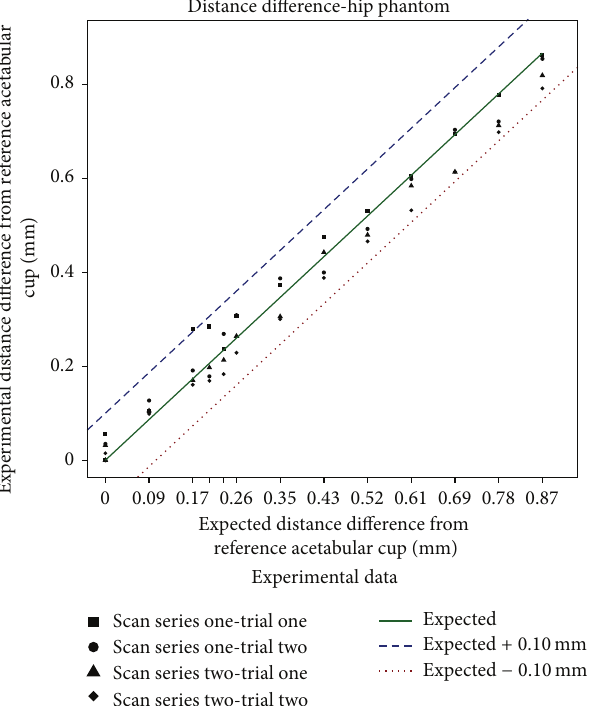
Figure 7: The calculated CupHeadSeparation plotted against the expected CupHeadSeparation from Table 1, for scan series one and two (both trials). Lines are drawn at the exact expected value and at ± 0.1 mm demonstrating the data were within 0.1mm of the expected